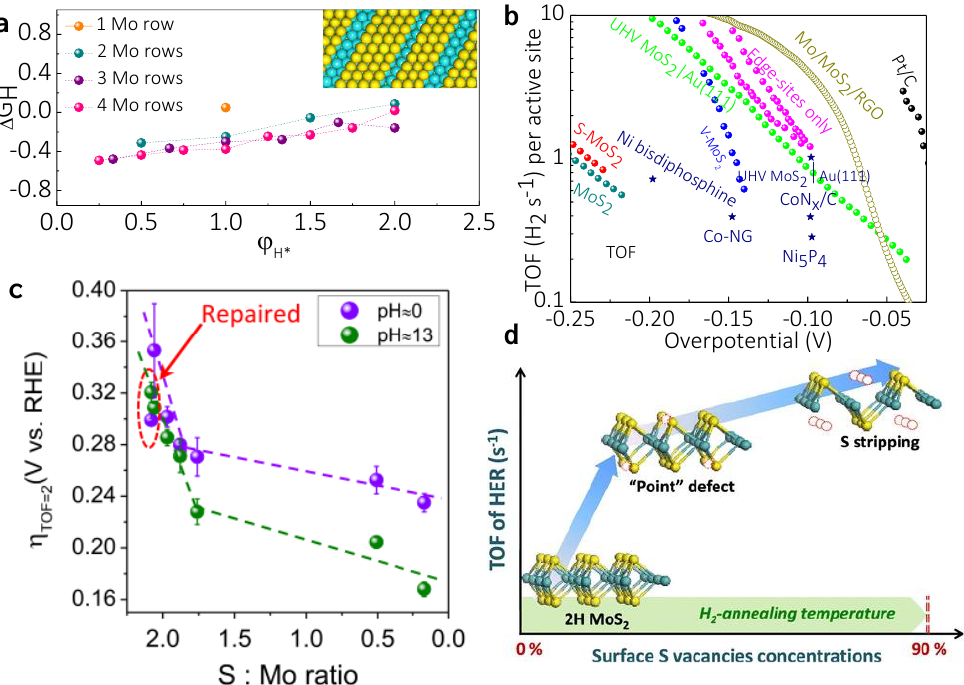
Figure 2. ( a ) Gibbs free energy ( ∆ G H ) versus hydrogen coverage ( φ H) for MoS 2 with different rows of S chains. The insert is the atomic structure depicting linear defects created by successive removal of S atoms along a row. ( b ) Calculated turnover frequency (TOF) of recently reported MoS 2 -based HER electrocatalysts [19]. ( a , b ) Adapted with permission from [19]. Copyright 2019 Elsevier. ( c ) Turnover frequency (TOF) from defective MoS 2 nanosheets. ( d ) The influence of controlled surface S vacancies of MoS 2 on their performance toward hydrogen production [14]. ( c , d ) Adapted with permission from [14]. Copyright 2019 American Chemical Society.